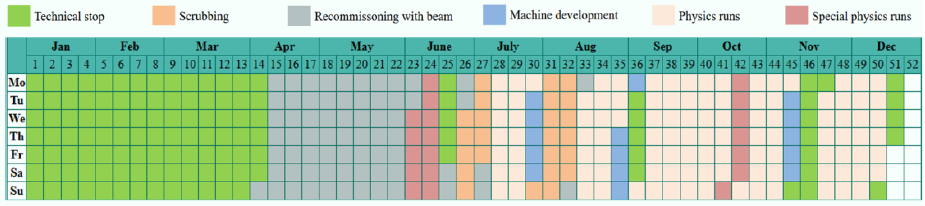
Table 2. LHC beam type and collision rates planned for Run